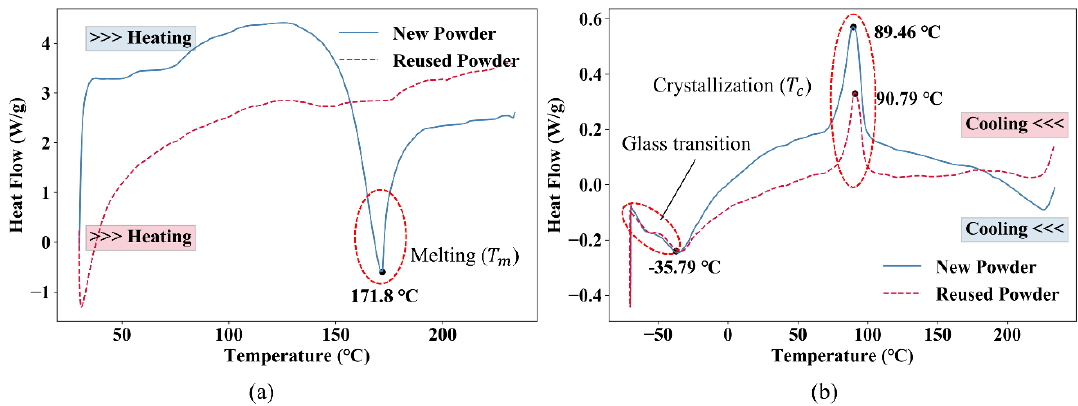
Figure 19. Differential scanning calorimetry (DSC) traces of the new powder and the reused powder: ( a ) heating traces and ( b ) cooling traces.